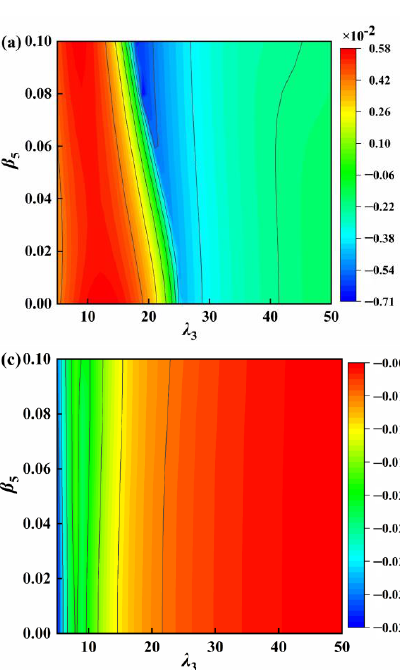
Figure 10. The root-mean-square of u 1 based on the values of the optimal parameter: ( a ) β 4 ; ( b ) β 5 . 4.4. Impulse Response Figure 11 illustrates the transient responses of u 1 with different initial velocity values applied on the mass m 1 . The solid black line and the dashed red line express the response of the primary without the vibration reduction and with the VS-TMD-I. It can be shown that the VS-TMD-I can improve the energy absorption rate with different initial impulse values. Moreover, the VS-TMD-I can reduce the time for the primary structure to reach steady state. In addition, the VS-TMD-I is effective for an extremely small initial impulse X = 0.01.